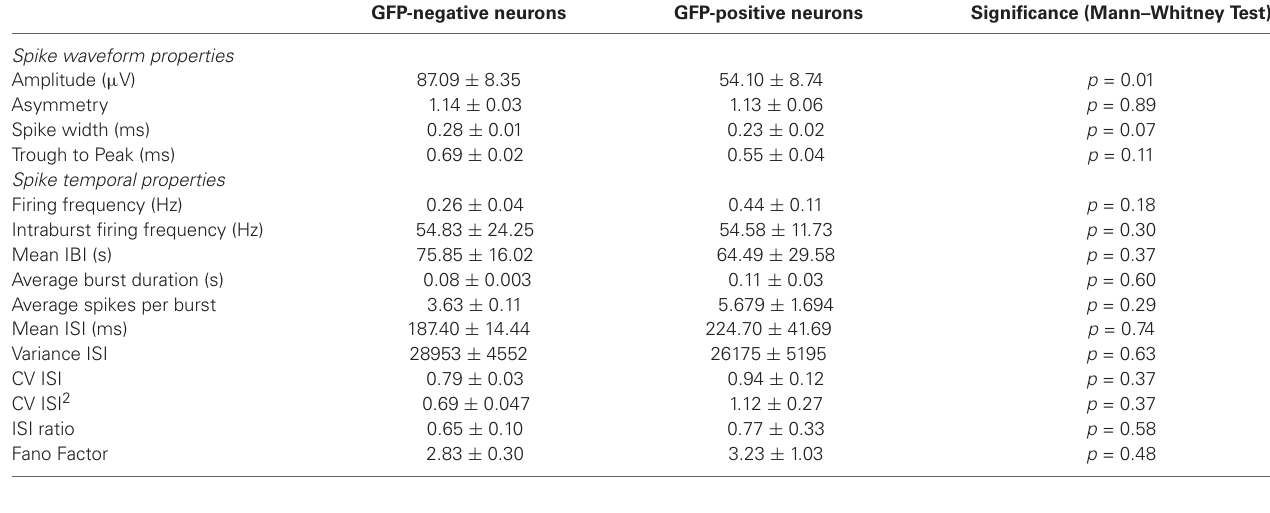
Table 1 | Properties of GFP-negative and GFP-positive neurons.